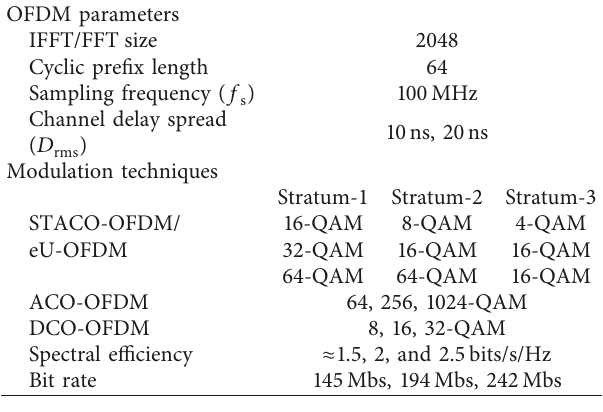
Table 1: Major simulation parameters.